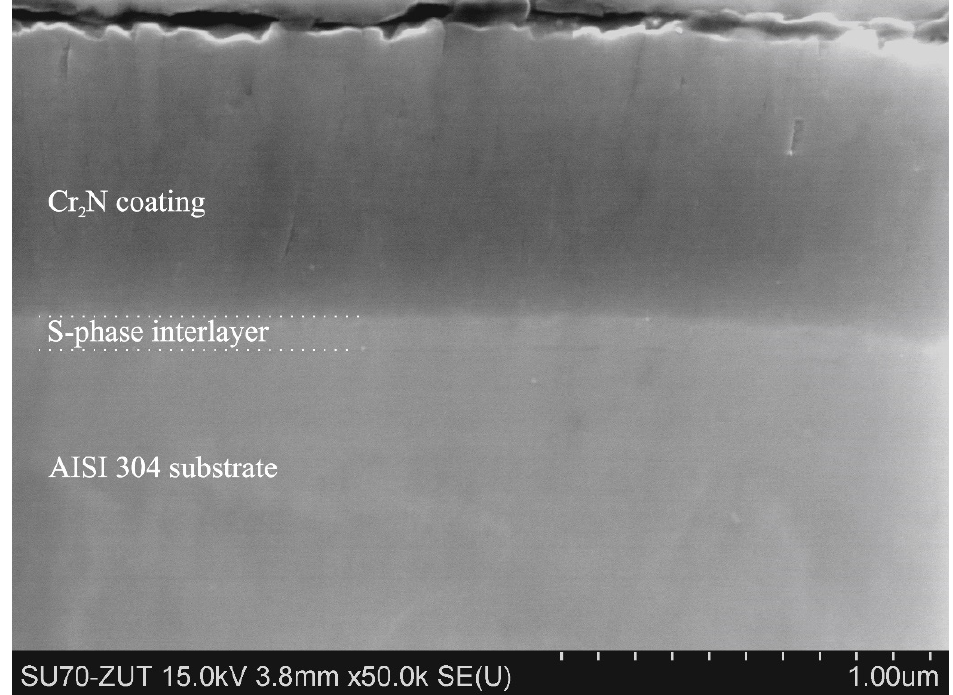
Figure 2. Cross-section of S-phase (30 vol.% of N 2 )/Cr 2 N coating deposited on substrate in delivery state, SEM.